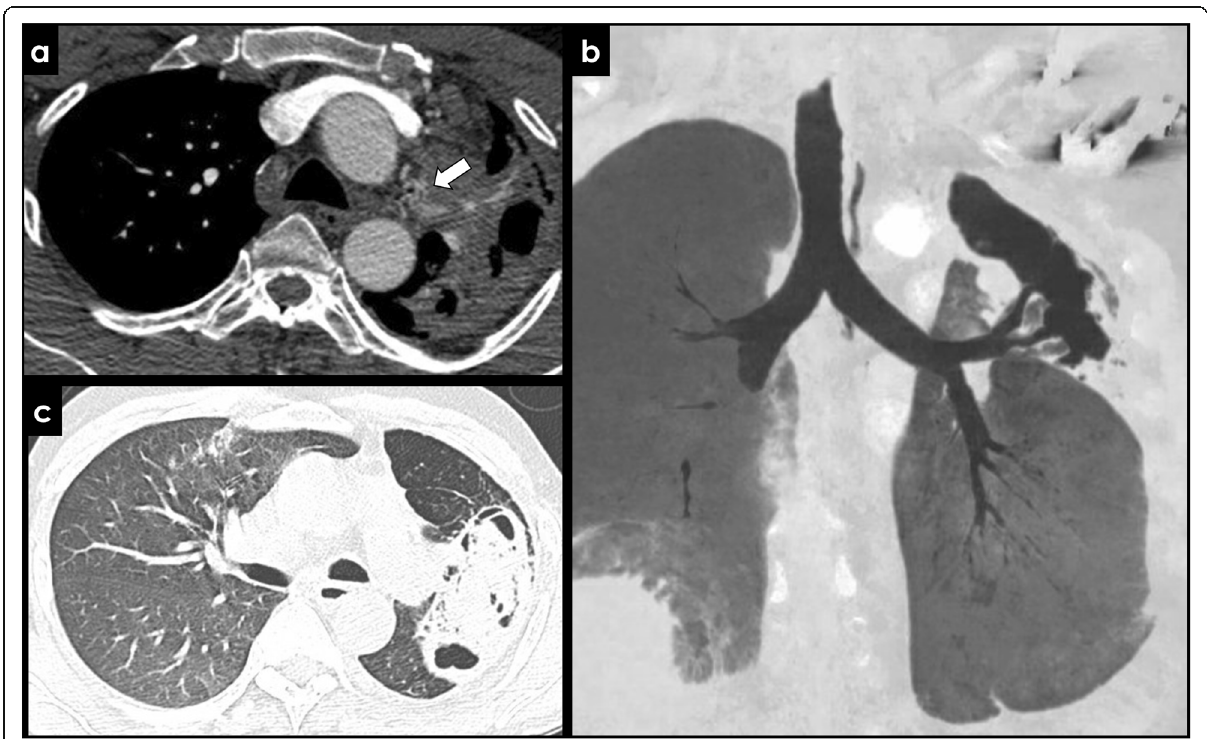
Fig. 9 Acquired causes of BAH — tuberculosis and aspergilloma. Left bronchial artery enlargement ( a , white arrow) in a patient with an aspergilloma complicating a left upper lobe cavity from tuberculosis ( c ). Image b represents the same patient 4 years before demonstrating an aerated cavity without signs of fungal